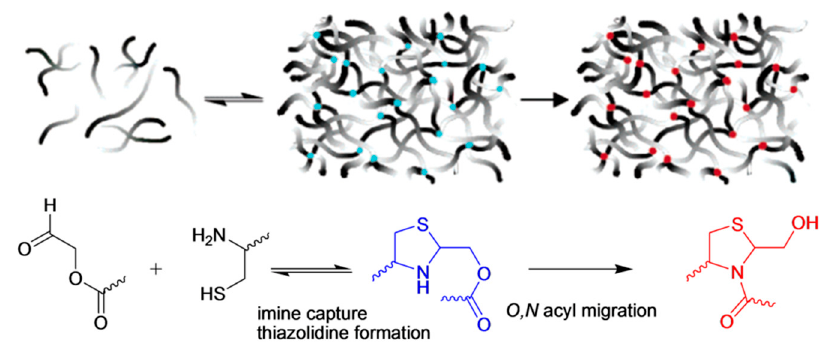
Figure 7. ( a ) Synthesis of peptide dendrons; ( b ) structure of macromers and the thiazolidine linkage; ( c ) synthesized hydrogel (left) and hydrogel sealant-repaired corneal incision. Adapted with permission from [22], Copyright © 2004 American Chemical Society.